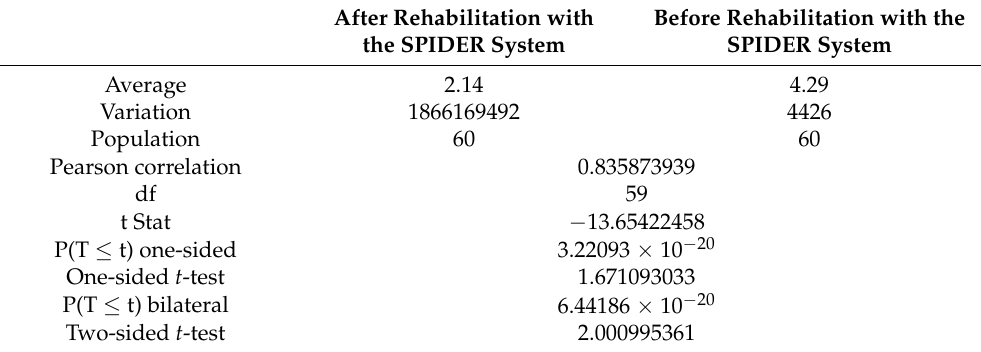
Table 4. The results of the statistical analysis of the average tilt before and after rehabilitation with the SPIDER system. After Rehabilitation with the SPIDER system. Before Rehabilitation with the SPIDER System